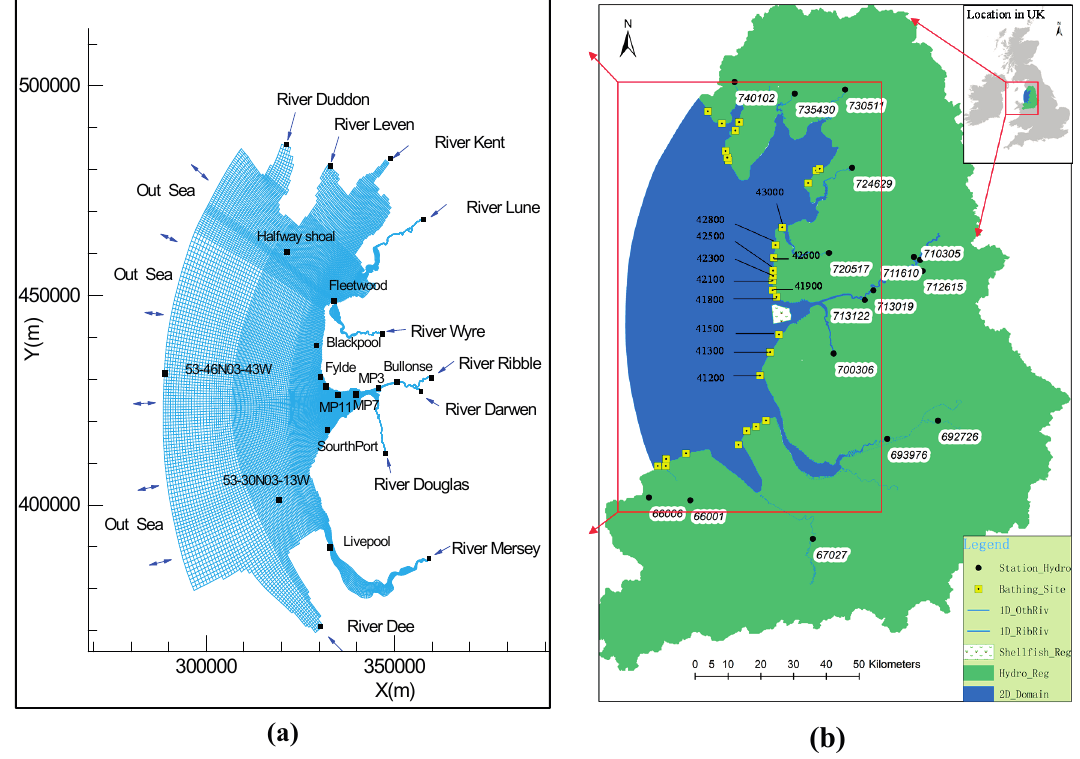
Figure 1. Maps of study domain, including: ( a ) the coastal model grid and monitoring sites for the riverine and coastal regions; and ( b ) the total model domain with catchment stations and coastal bathing